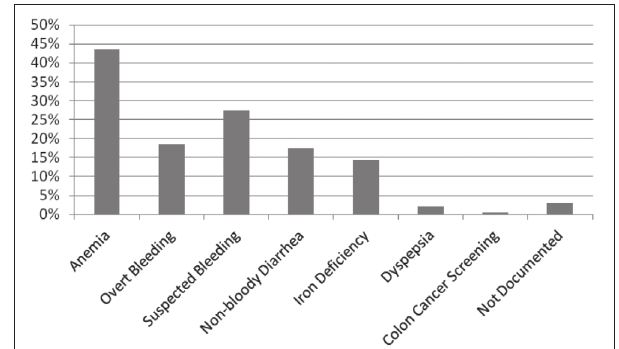
Figure 1) Indications for ordering fecal occult blood